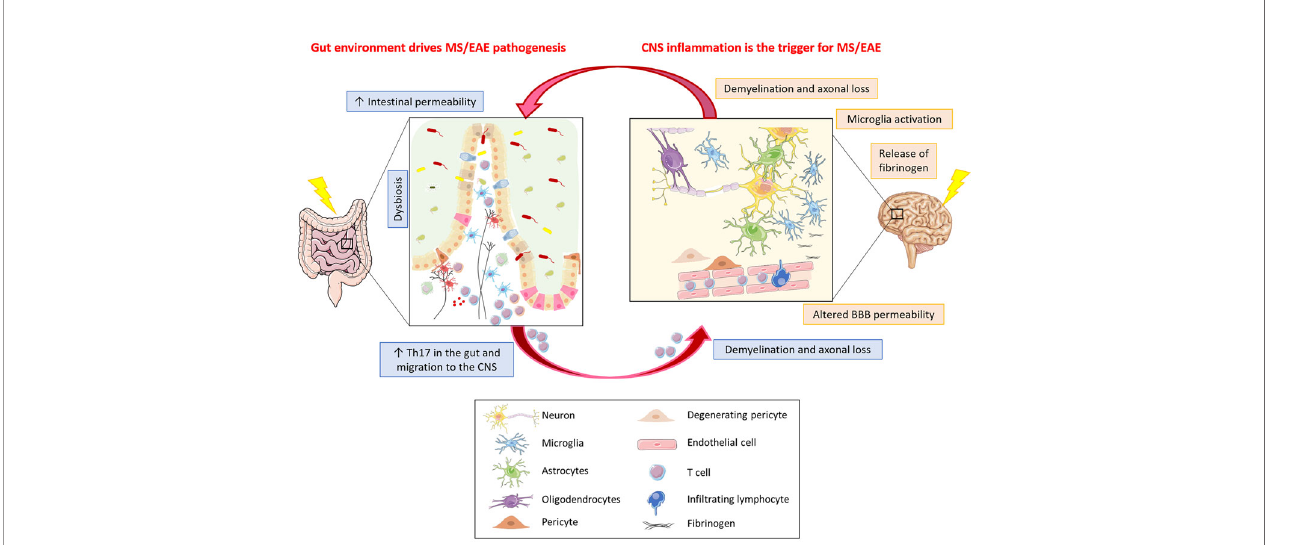
FIGURE 2 | What comes fi rst in MS, gut or CNS in fl ammation? Gut environment drives MS/EAE pathogenesis. In MS/EAE, dysbiosis together with an increased intestinal permeability, possibly due to alterations in intestinal epithelial barrier morphology, have been demonstrated. These alterations allow the translocation of microbes or their products from the gut lumen into the lamina propria, thereby promoting in fl ammation. In fl ammation in the gut can result in activation of encephalitogenic T cells that can travel to the CNS where they can induce in fl ammatory damage with subsequent demyelination and axonal loss. CNS in fl ammation is the trigger for MS/EAE. Neuroin fl ammation in MS/EAE could be the consequence of an altered vascular permeability of BBB. The leakage of plasma components, such as fi brinogen, leads to rapid activation of microglia that might be the trigger of the disease, with ensuing in fi ltration of homing in fl ammatory cells and signal transmission to the gut resulting in intestinal barrier permeability thereby propagating the brain-gut in fl ammation